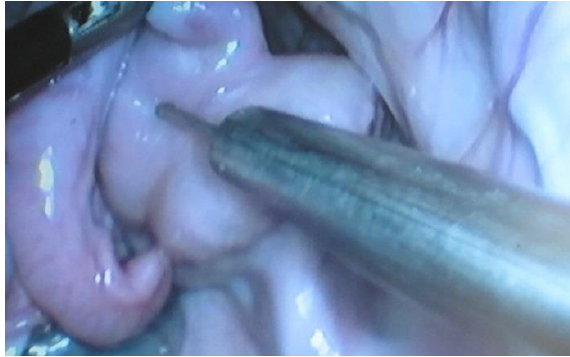
Figure, 5: Laparoscopical diagnosis ( white arrow ) of early pregnant goat uterus. Ovary ( black arrow ) contended small follicles and C.L.